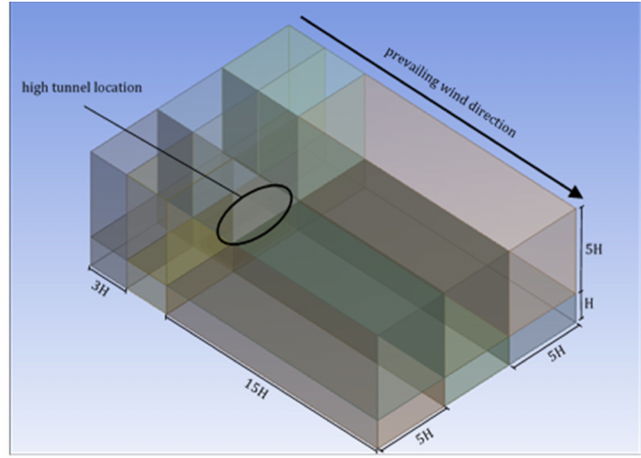
Figure 2. Computational domain used for the CFD